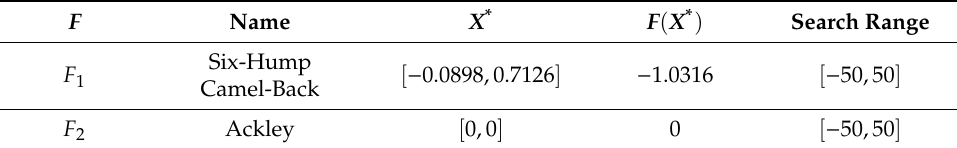
Table 1. Fundamental information of the benchmark functions.